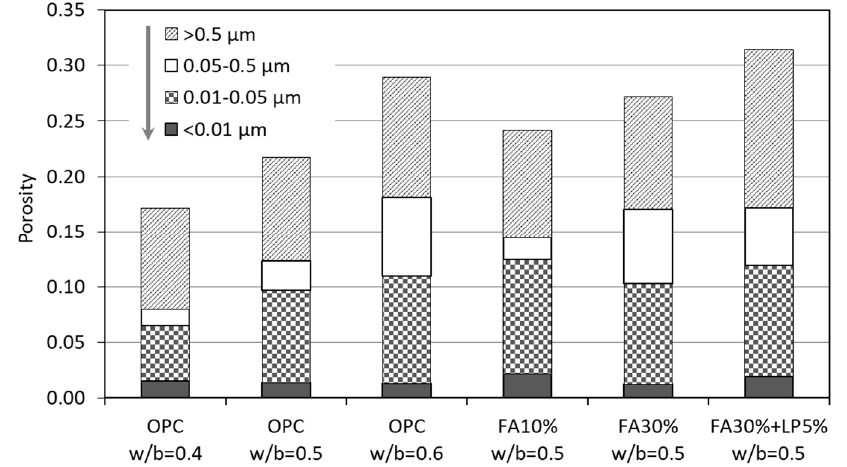
Figure 13. Pore size distribution of various cement pastes at 182 days obtained by PDC-MIP tests.